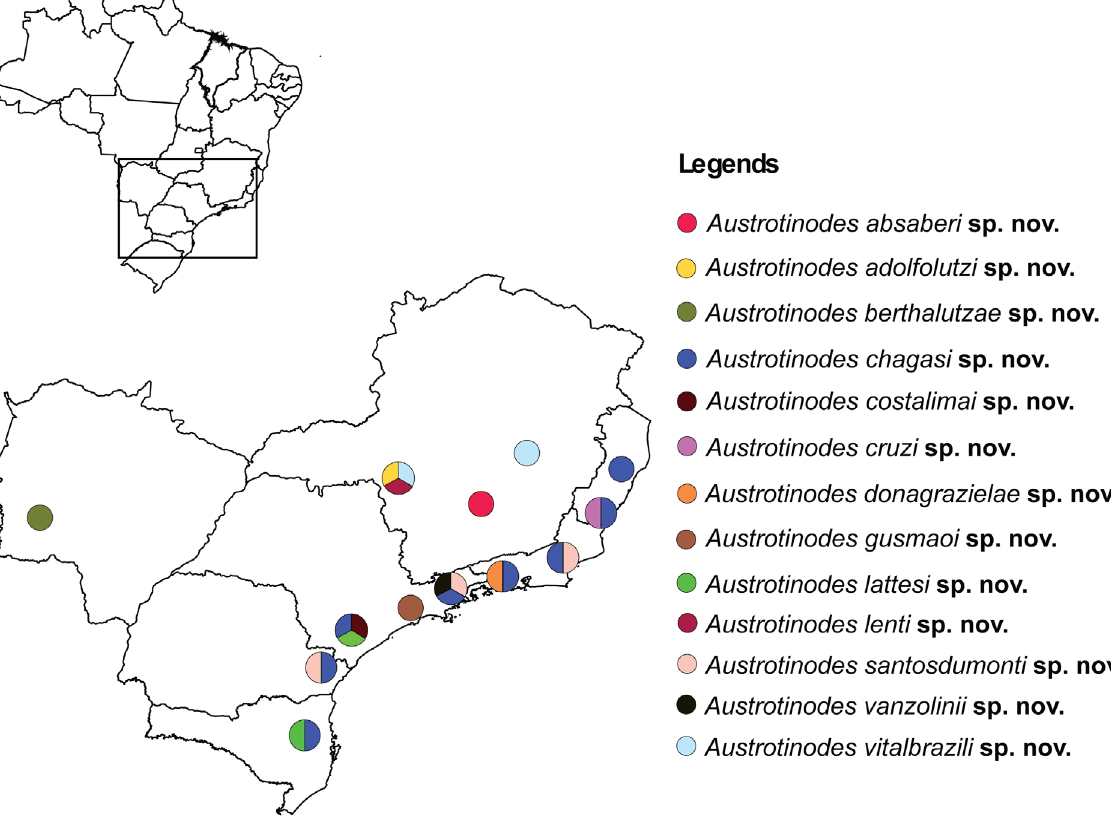
Fig. 14. Distribution map of the new species of